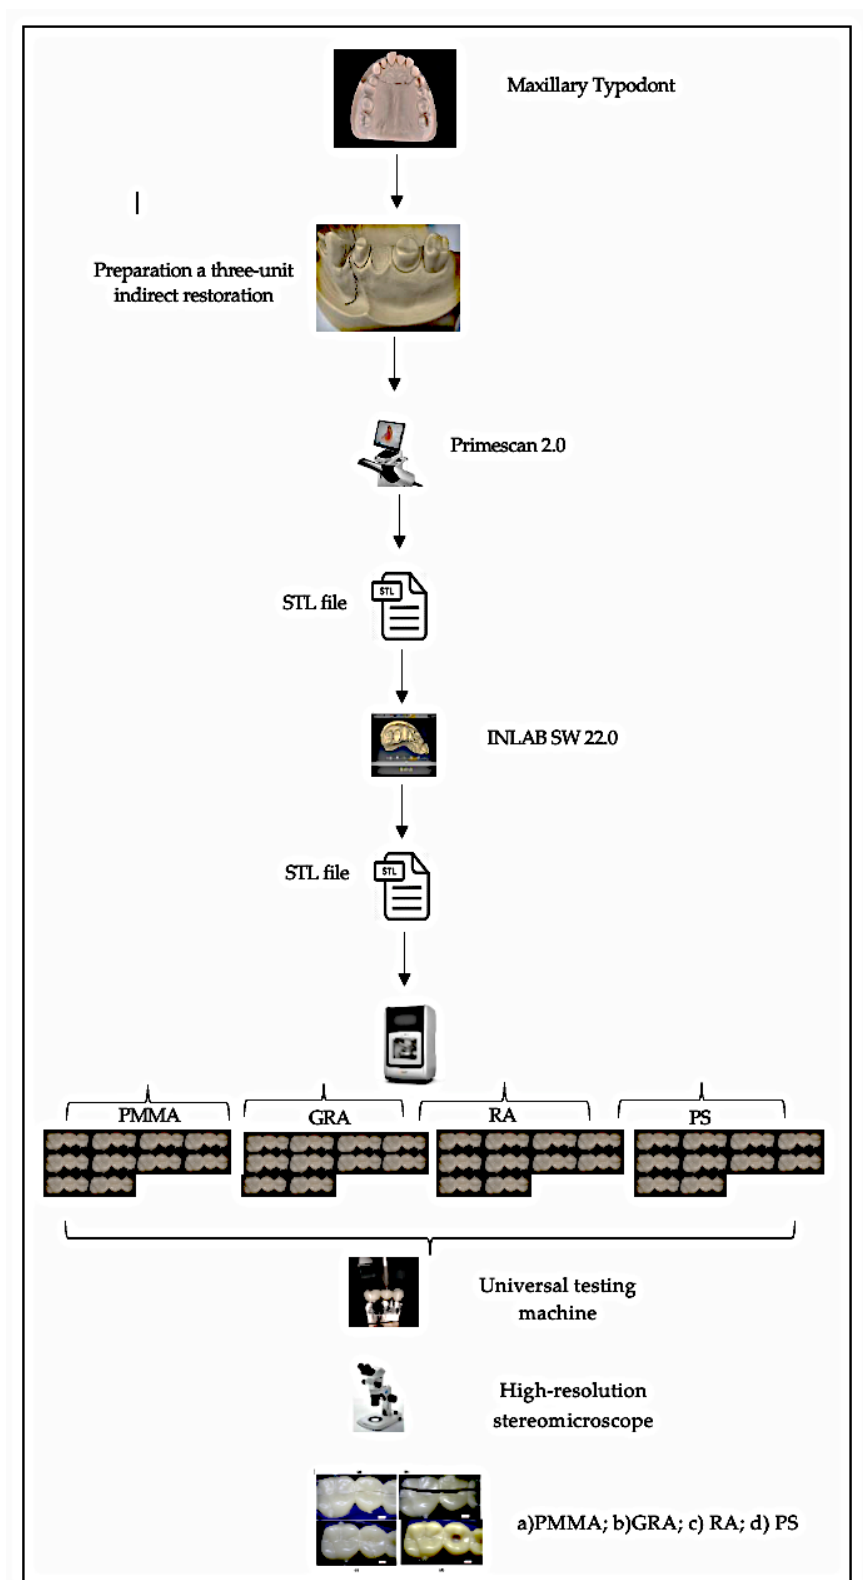
Figure 1. Scheme of the methodology used in this study.